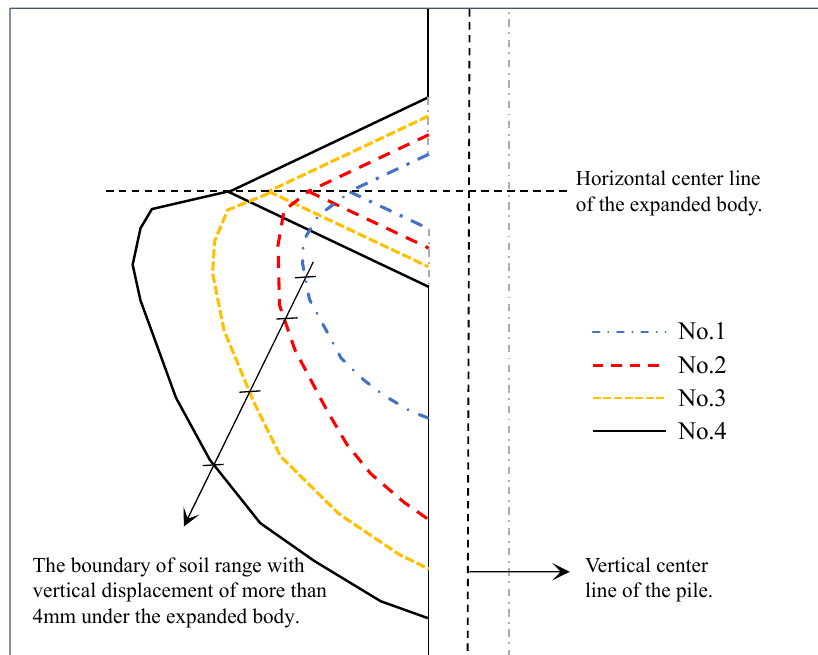
Figure 15. Schematic diagram of the range of vertical displacement above 4 mm around the pile with di ff erent expanded diameters.